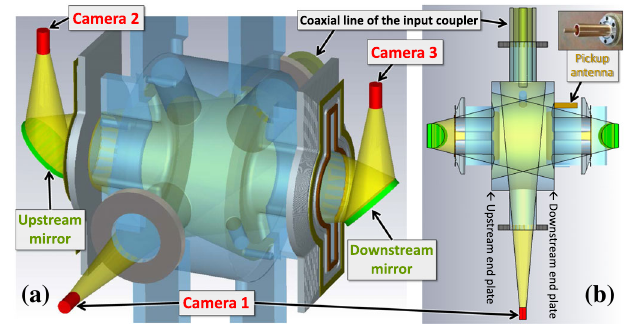
FIG. 5. (a) Schematic of the experimental setup for multidi- rectional and wide-field observation. The red cylinders and yellow regions represent the three cameras and their fields of view, respectively. During the high-power test, the inside of the cavity (blue) was a vacuum, and the mirrors (green) [shown in Fig. 4(a)] were contained in the mirror chambers. (b) Cross- sectional view of the experimental setup along the horizontal plane including the center of the